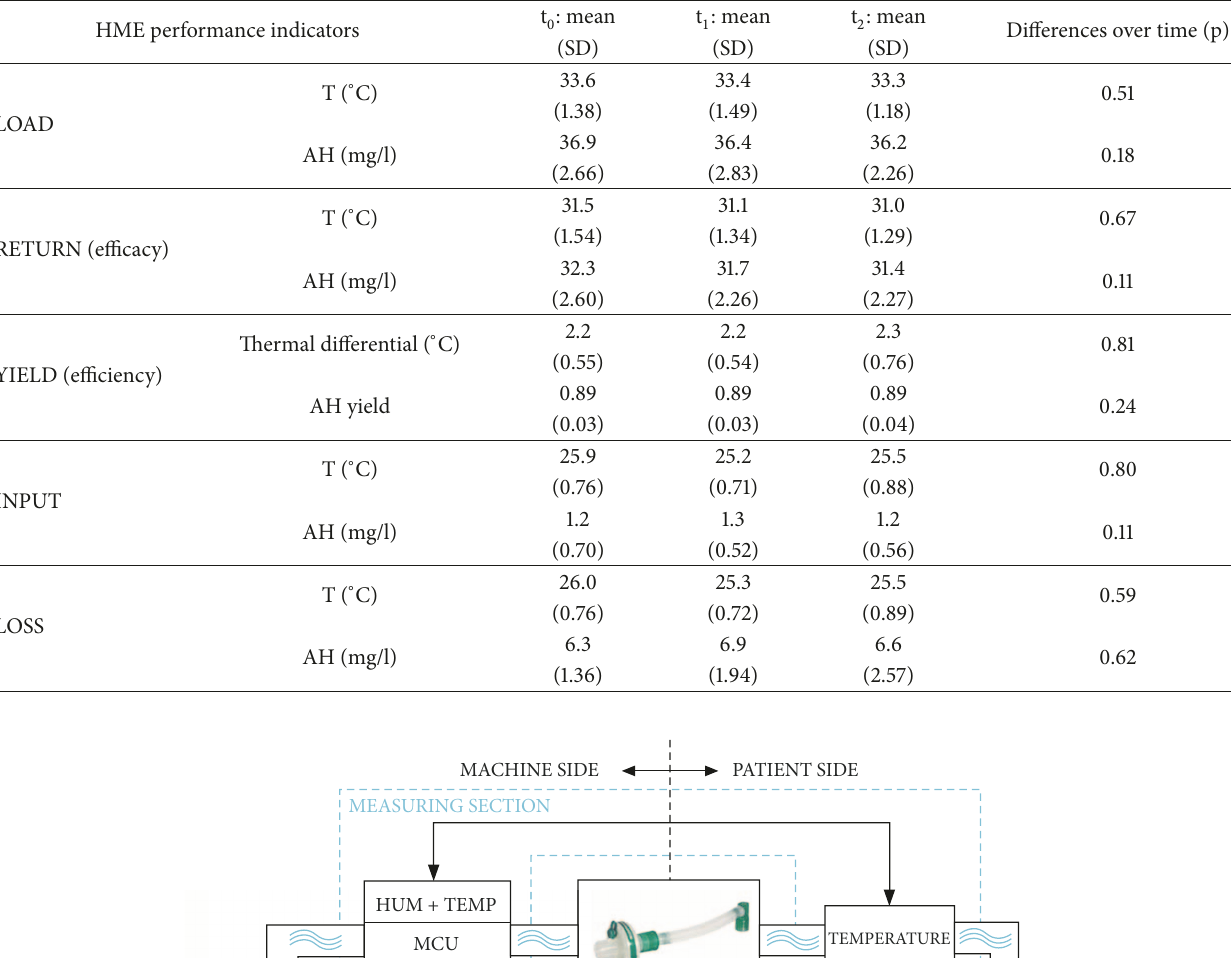
Table 2: Temperature (T) and absolute humidity (AH) values of Heat and Moisture Exchanger (HME) performance indicators; SD: standard deviation.